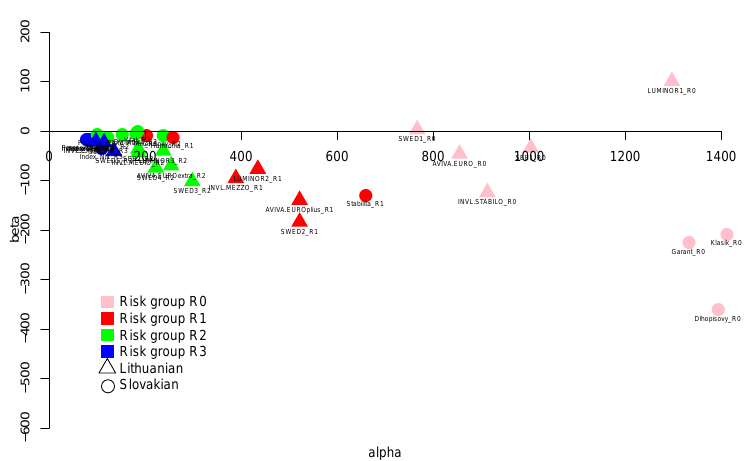
Figure 5. Scatter plot of estimates of shape and asymmetry parameters of hyperbolic distribution for Slovak and Lithuanian pension funds.